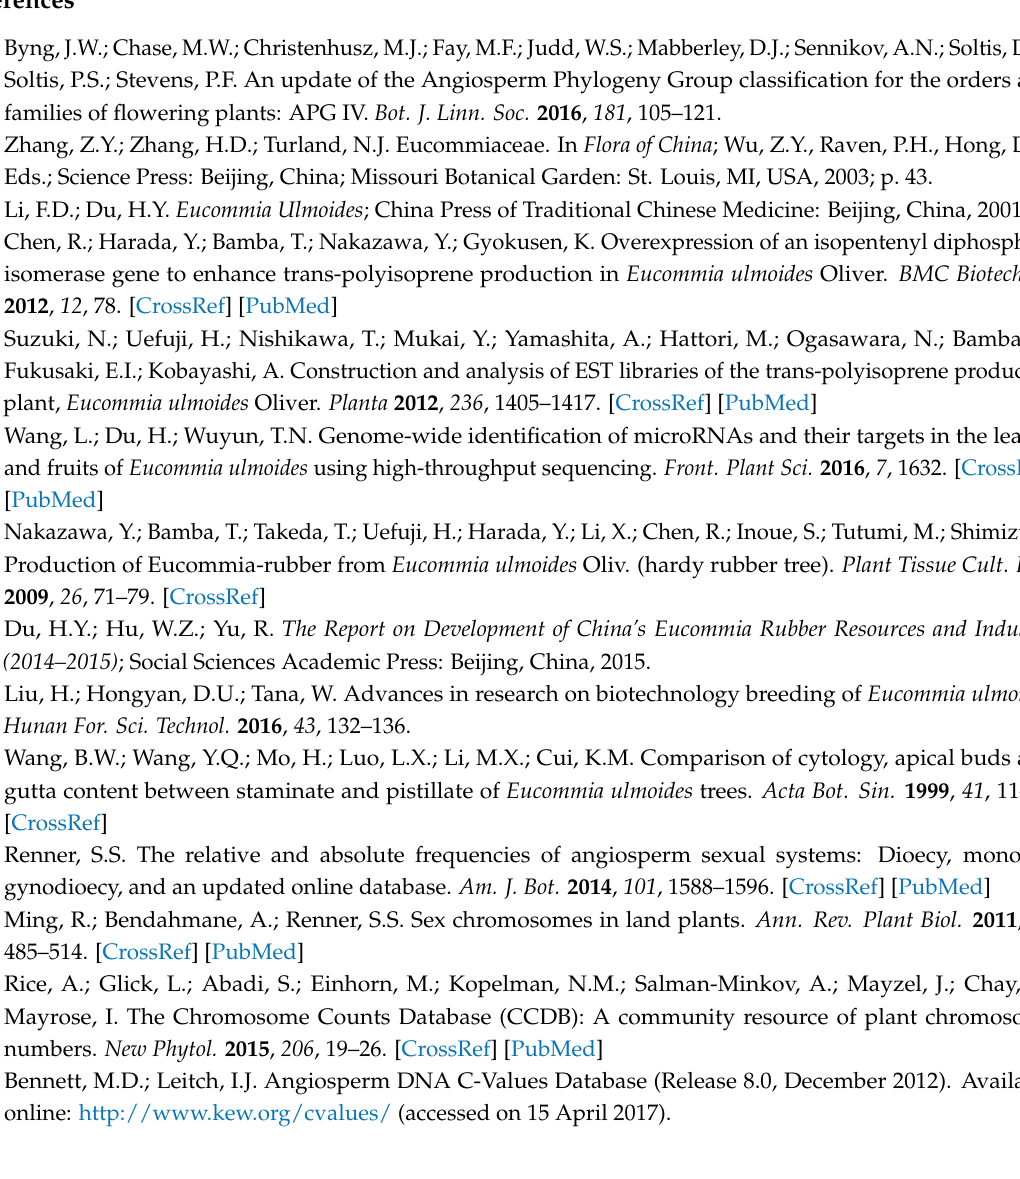
Supplementary Materials: Supplementary materials are available online. Table S1: Annotation information of non-redundant consensus sequences of Eucommia ulmoides . Table S2: The functional annotation and enrichment analysis of DEGs (differentially expressed genes) between the males and the females of Eucommia ulmoides . Table S3: The putative MADS box TF (transcription factor) genes in Eucommia ulmoides . Table S4: The SNPs (single nucleotide polymorphisms) calling in DEGs (differentially expressed genes) between the males and the females of Eucommia ulmoides . Table S5: SNPs (single nucleotide polymorphisms) occurrence in the expressed genes in each Eucommia ulmoides individual. Figure S1: The pathway of pyruvate metabolism. Two unigenes of Eucommia ulmoides were assigned to the pyruvate metabolism by KEGG enrichment analysis. The gene/protein name in a red and green box represents male- and female-biased genes,